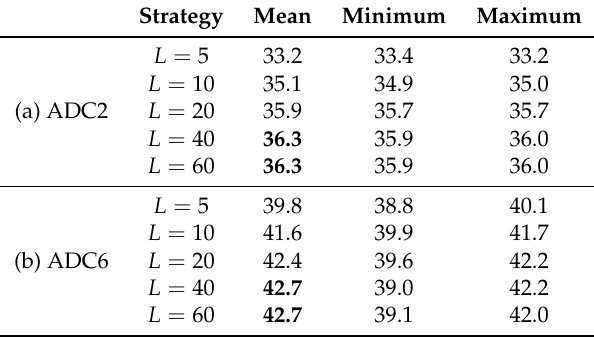
Table 3. Average FScore of adapted detectors for different strategies to select a threshold τ n , m n from